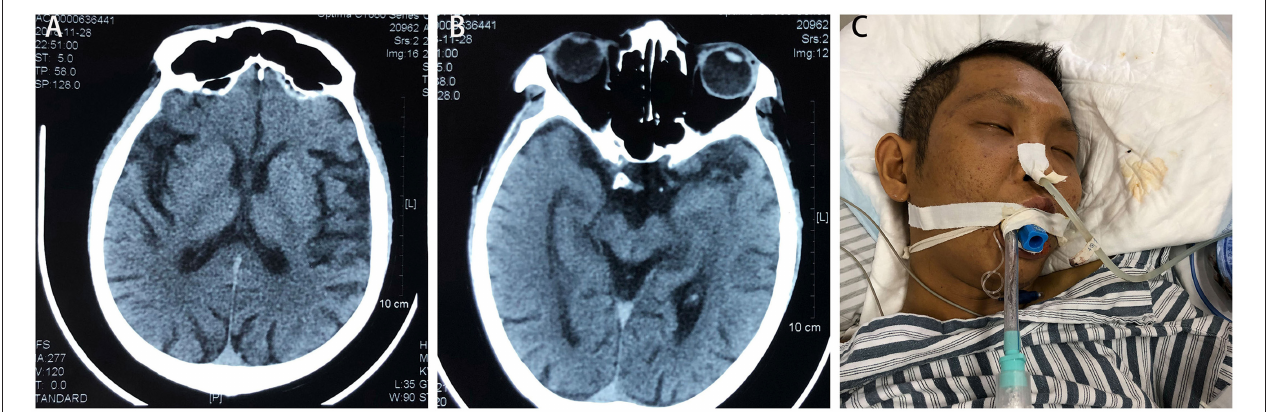
FIGURE 1 | Craniocerebral computed tomography scan indicates wide and deep cerebral sulcus, flattened cerebral palsy, expanded ventricles, thickened cerebellum and reduced brain volume (A,B) . (C) The patient was placed on a ventilator but soon died of persistent epilepsy and multiple organ